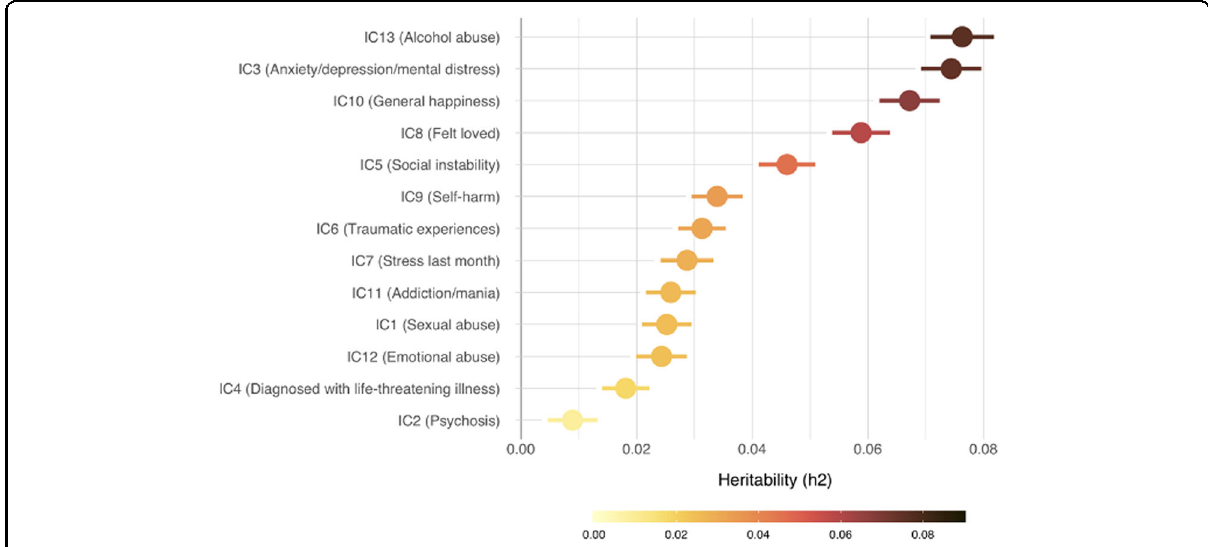
Fig. 2 Heritability estimates of the independent components SNP-based heritability for each IC sorted by decreasing heritability ( h 2). Heritability calculated using the LDSC toolbox 41 . Error bars re fl ect standard